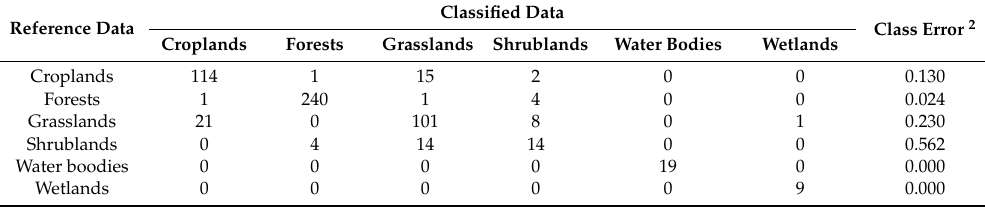
Table 7. Confusion matrix of land cover classification for 2015.